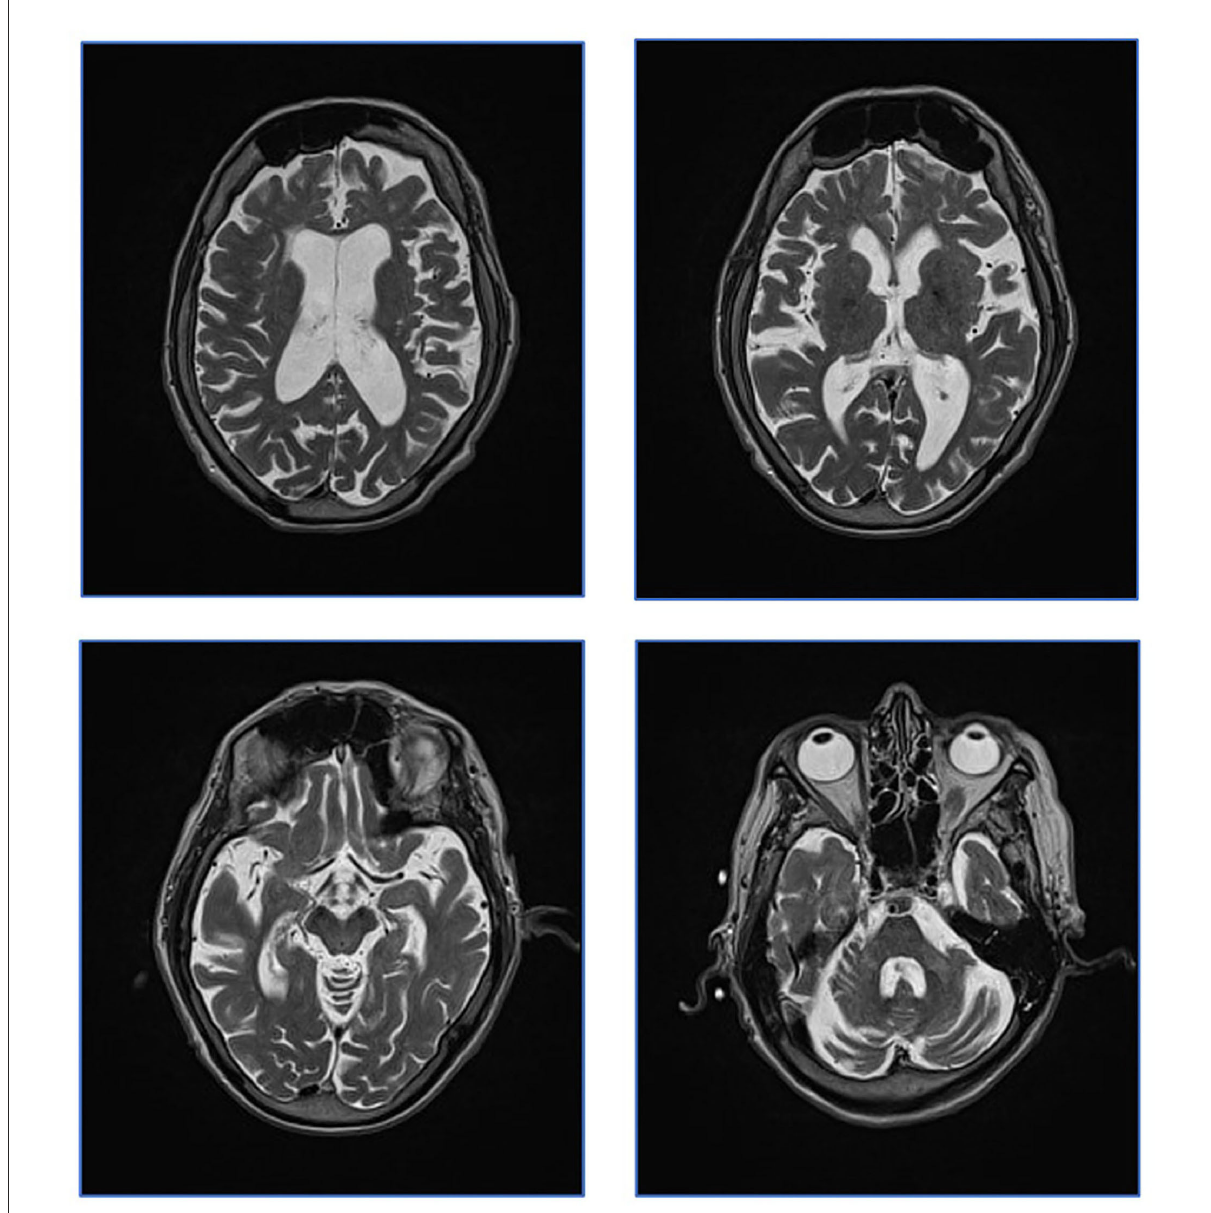
FIGURE1 Patient MRI from 2017. Patient MRI. Axial T2 weighed images showing global atrophy and unspecific T2 hyperintensities. Characteristic WD changes to basal ganglia were not